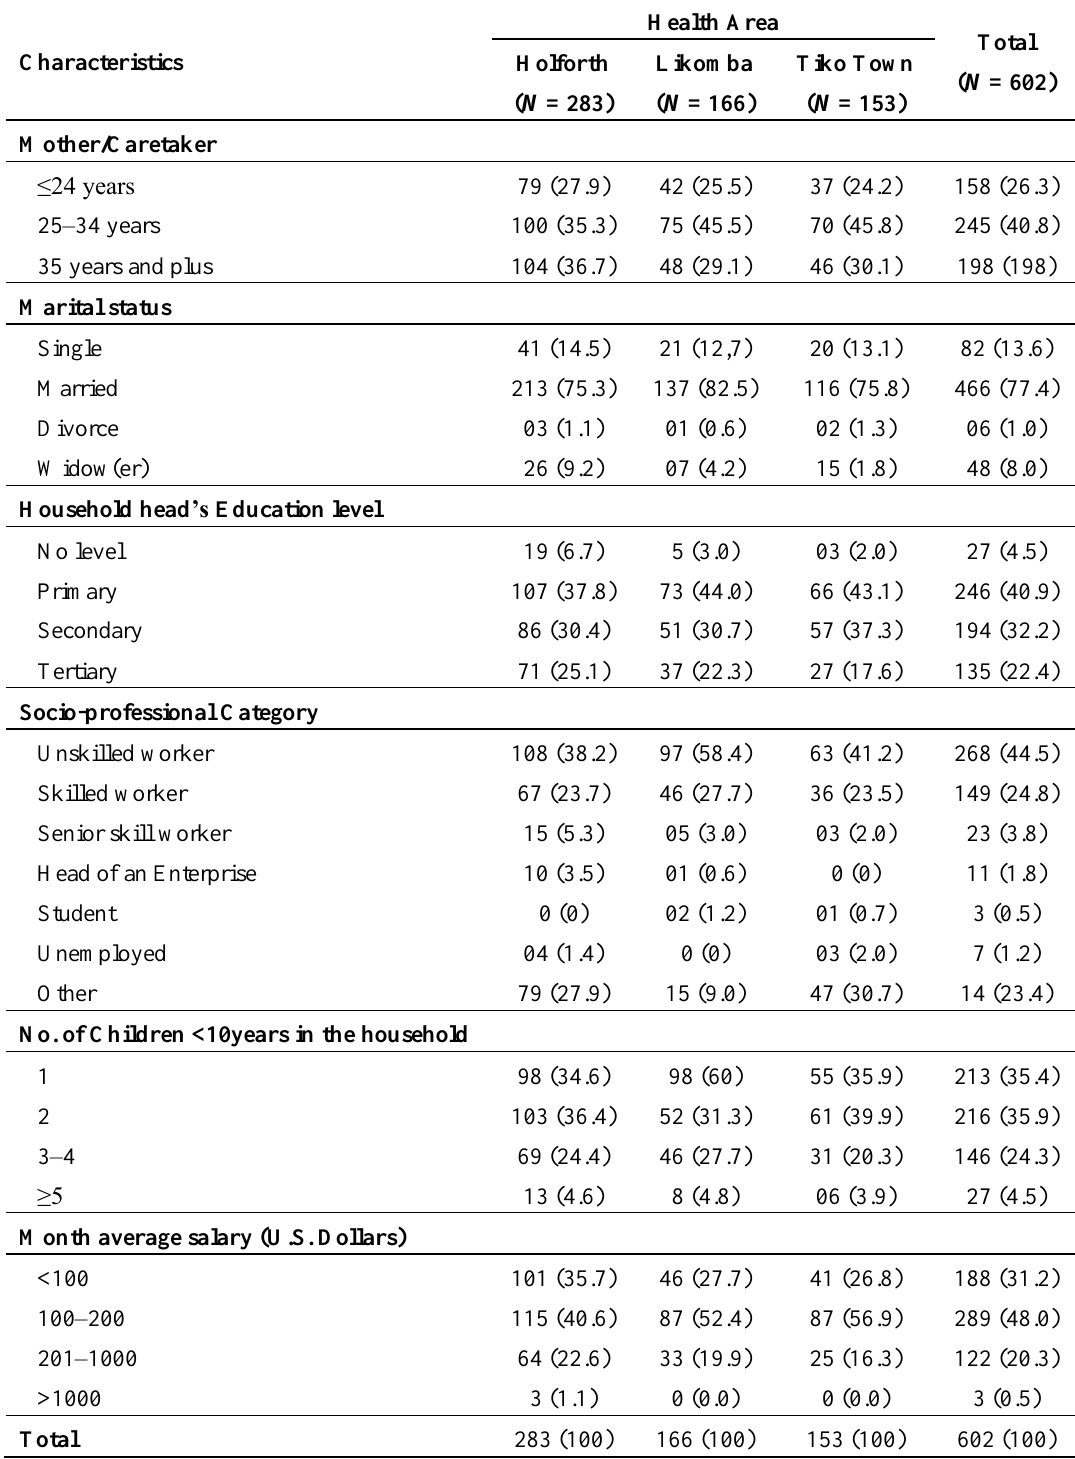
Table 1. Demographic and socioeconomic characteristics of households in Tiko City, 2012.